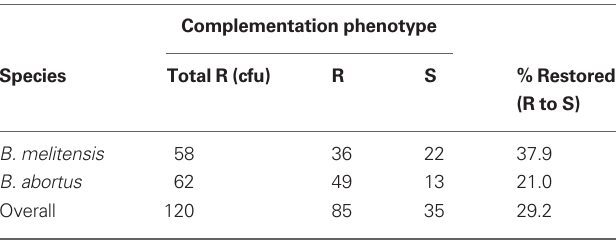
Table 3 | Complementation test with spontaneous rough isolates and plasmid pJET1445.